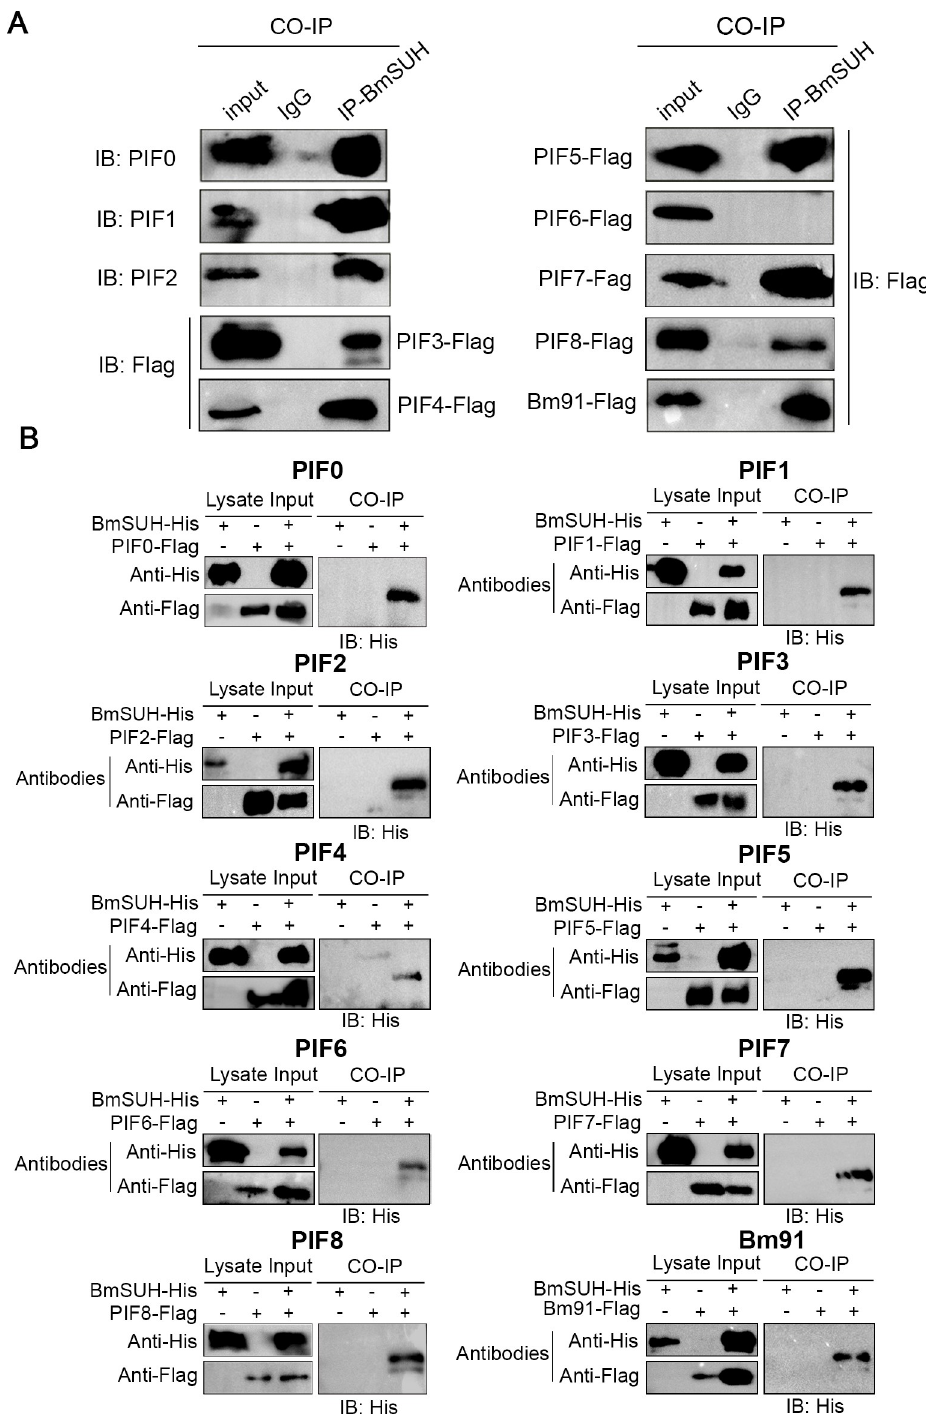
Fig 6. Co-immunoprecipitation analysis of interactions between different PIFs and BmSUH protein. (A) Co-IP analysis of BmSUH in NPV-infected BmN cells. BmN cells were infected with recombinant viruses expressing BmSUH-His or co-infected with BmSUH-His and PIFs-Flag. Immunoprecipitation (IP) was performed using anti- BmSUH or anti-IgG antibody followed by immunoblotting (IB) with anti-PIF0, anti-PIF1, anti-PIF2 or anti-Flag antibody individually. (B) BmN cells that were infected or co-infected with recombinant viruses expressing BmSUH-His or/and a Flag-tagged PIFs were subjected to anti-Flag. Inputs and eluates were analyzed by immunoblotting with